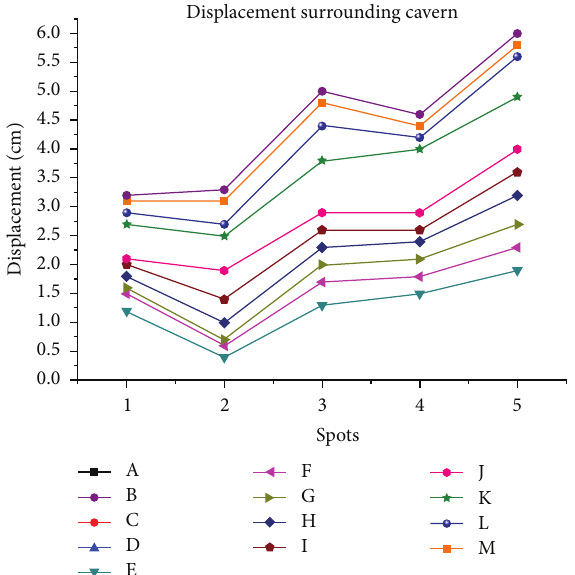
Figure 12: Displacement distribution surrounding the cavern.